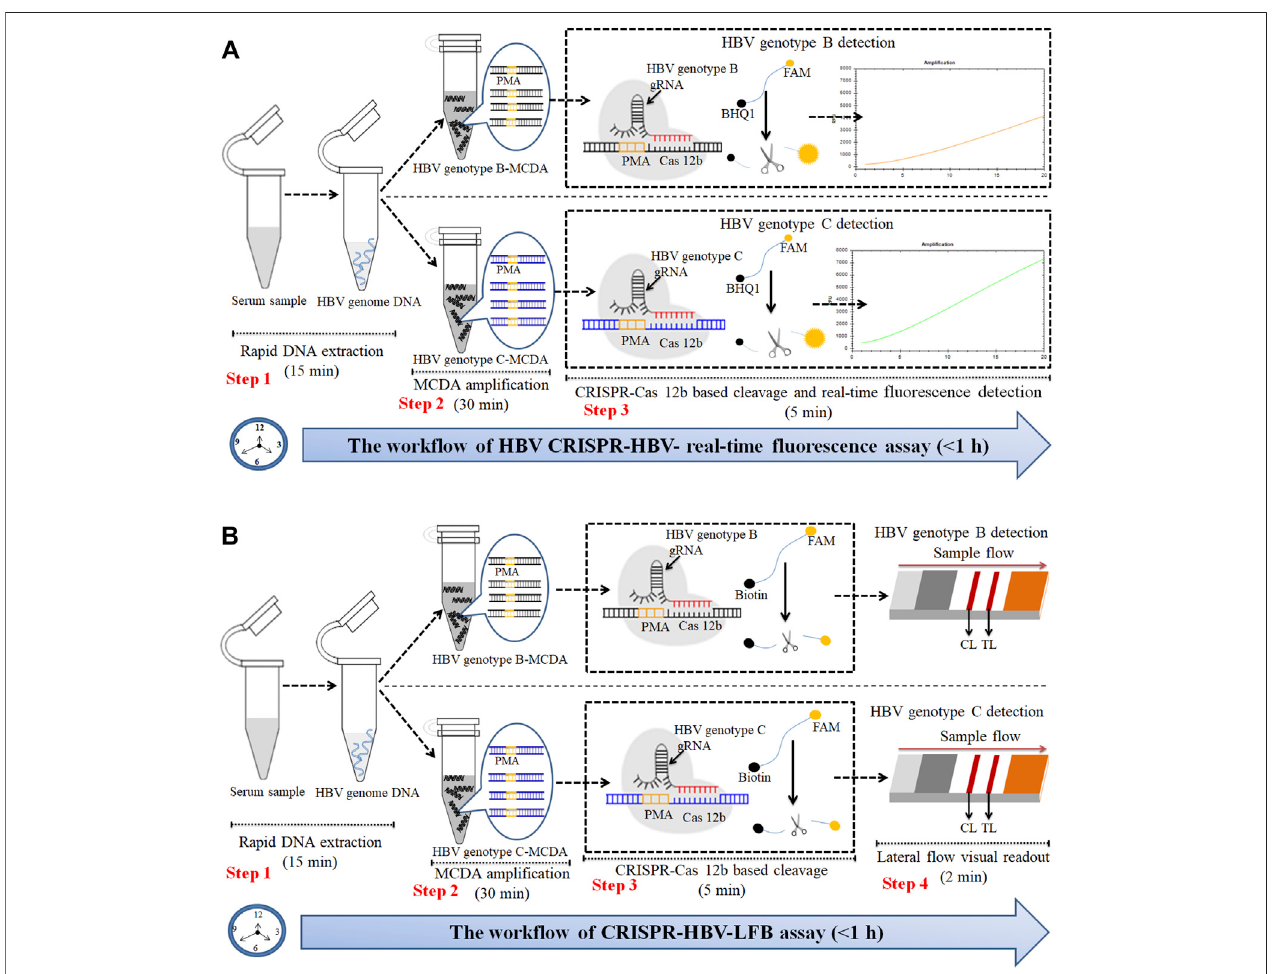
FIGURE2| AnoutlineoftheCRISPR-HBVwork fl ow. (A) TheCRISPR-HBV RTFassayemploysthreecloselylinkedsteps:DNAextraction(step1),MCDA(step2), and CRISPR-Cas12b cleavage and RTF readout (step 3). The whole detection process could be completed within 1 h. (B) CRISPR-HBV – LFB assay employs four closely linked steps: DNA extraction (step 1), MCDA (step 2), CRISPR-Cas12b cleavage (step 3), and LFB readout (step 4). The whole detection process could be completed within 60 min.